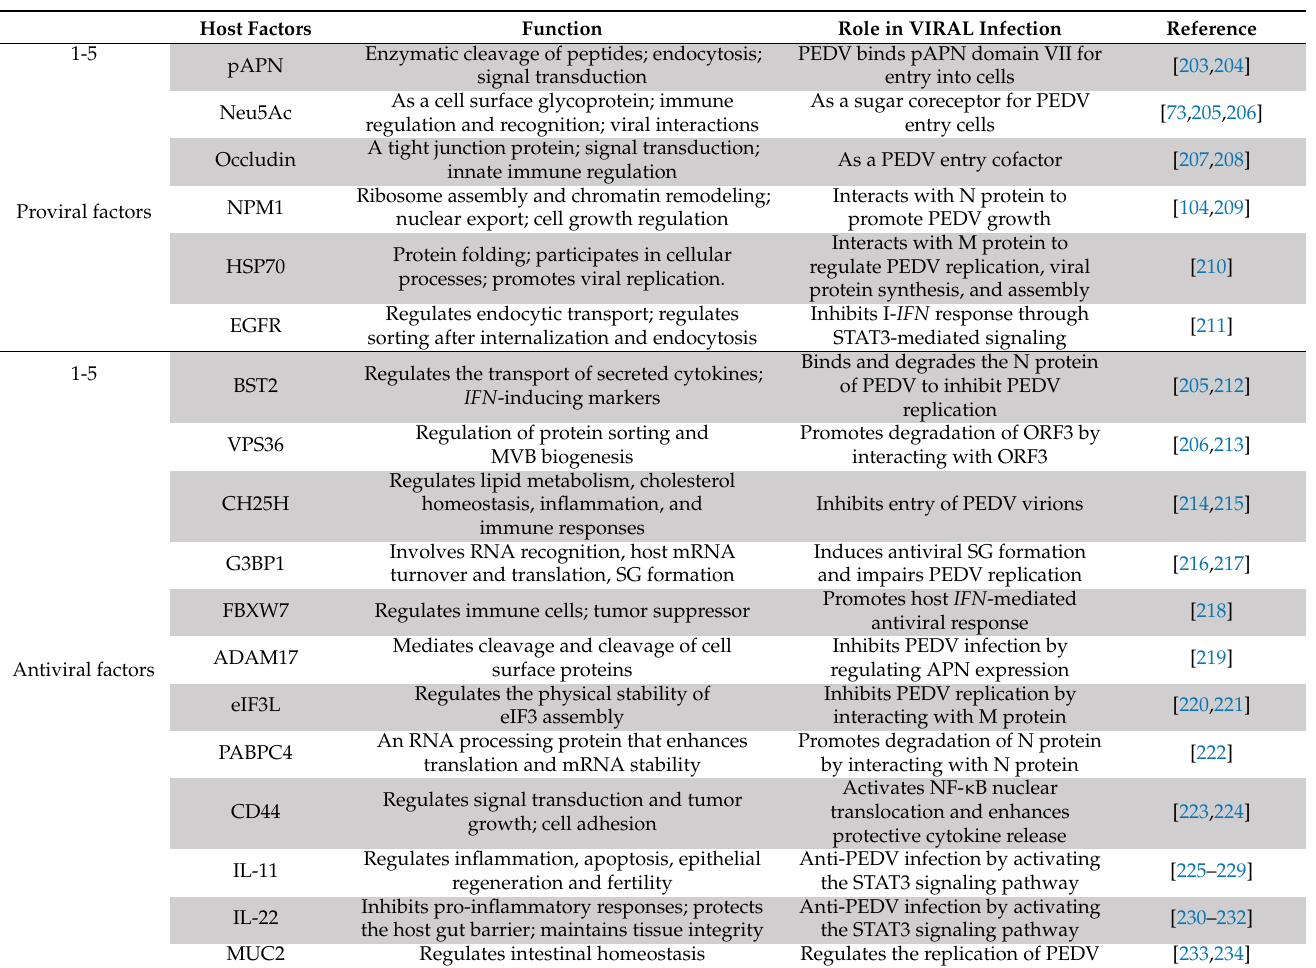
Table 4. An overview of host